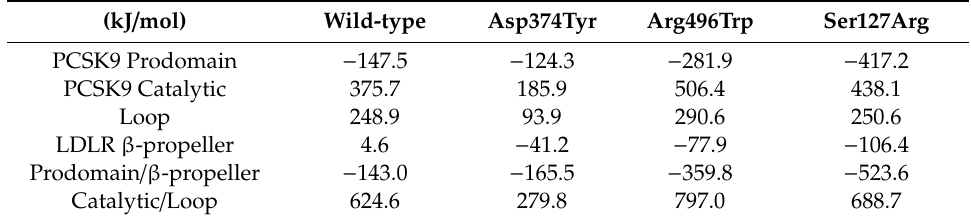
Table 2. A per-residue decomposition of the binding a ffi nities grouped by domain and interaction. (kJ /